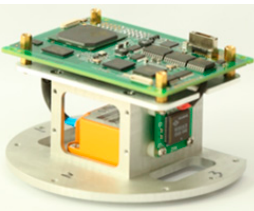
Figure 1. MEMS inertial measurement units.